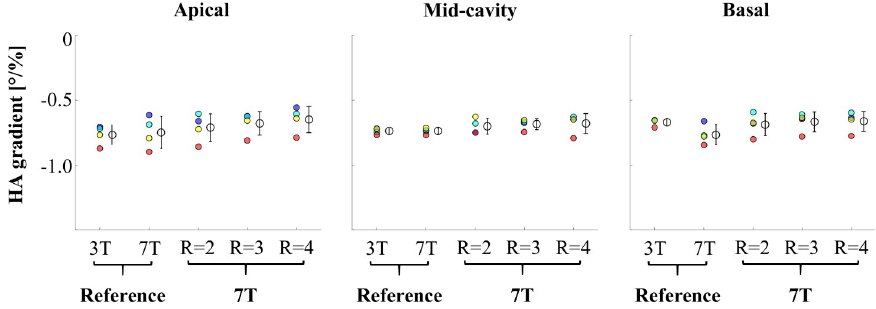
Fig 6. Transmural helix angle gradients between transmural layers. Endocardial, sub-endocardial, mid-wall, sub- epicardial, and epicardial. Gradients were calculated based on the data displayed in Fig 4. Color coding: Endo- to sub- endocardial gradient (blue), sub-endocardial to mid-wall gradient (light blue), mid-wall to sub-epicardial gradient (yellow), and sub-epicardial to epicardial gradient (red). The complete transmural gradient is displayed with mean ± one standard